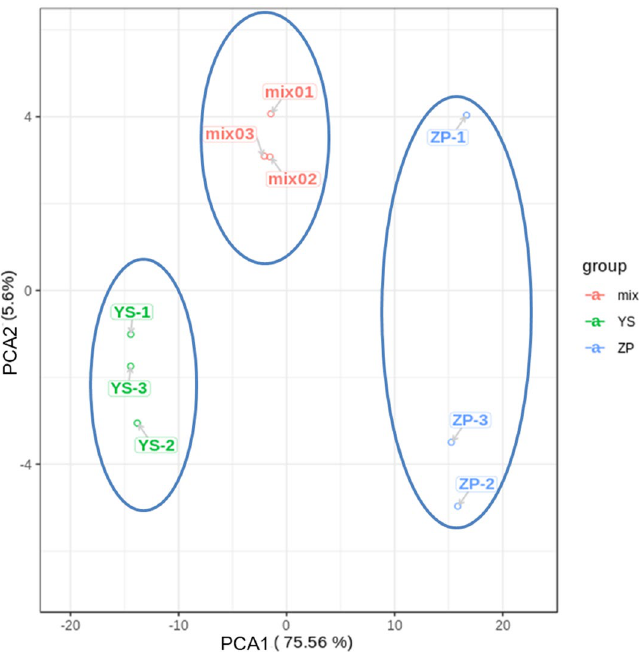
Figure 1. PCA score chart based on mass spectrum data of ZP, YS and QC samples. Ordinate: the second principal component, Abscissa: the first principal component. PCA Plot visualized in ggplot2 toolkit of R v3.5.0 (https:// www.r- proje ct. org/).